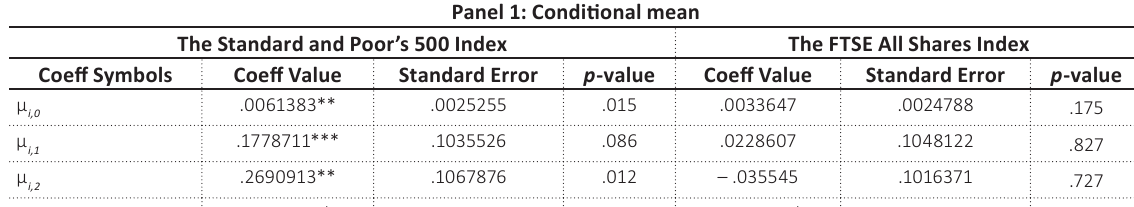
Table 7. AG model